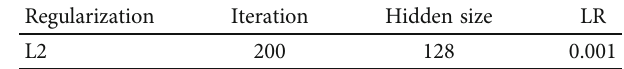
Table 1: Hyperparameter in